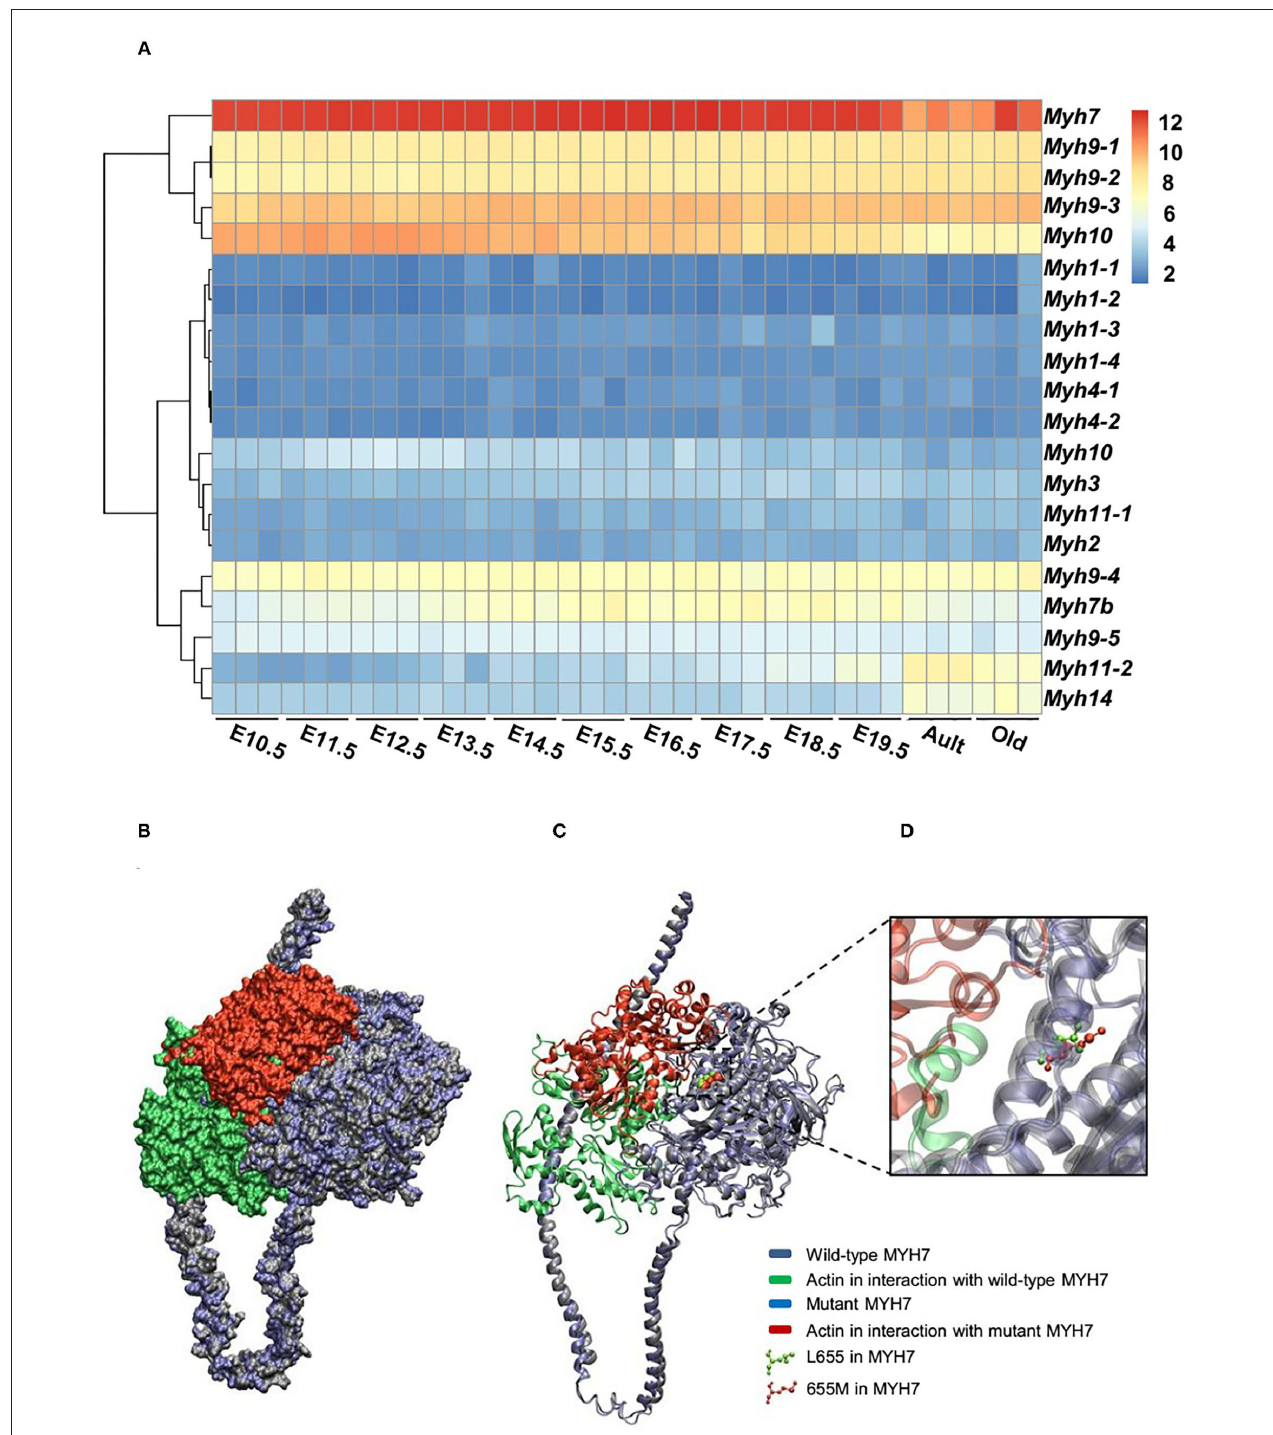
FIGURE 3 | Expression patterns of all MYH superfamily members during cardiac development. (A) Differential expression pattern of MYH7 in the mouse heart during 12 stages of development indicates that the expression of this gene plays an important role in the mouse cardiogenesis, especially during embryonic life. (B) Modeling scheme of the protein-protein interaction between native MYH7 /actin and MYH7 p.Leu655Met/actin at the surface. Actin in the wild-type position is shown in green and in the mutant position, is shown in red. (C) Secondary structure cartoon representation. Actin in the wild-type position is shown in green, and in the mutant position, is shown in red. (D) The Leu655Met mutation is highlighted. Wild MYH7 protein (Leu 655) is shown in green, and the protein that has the mutated residue (Met 655) is shown in red.